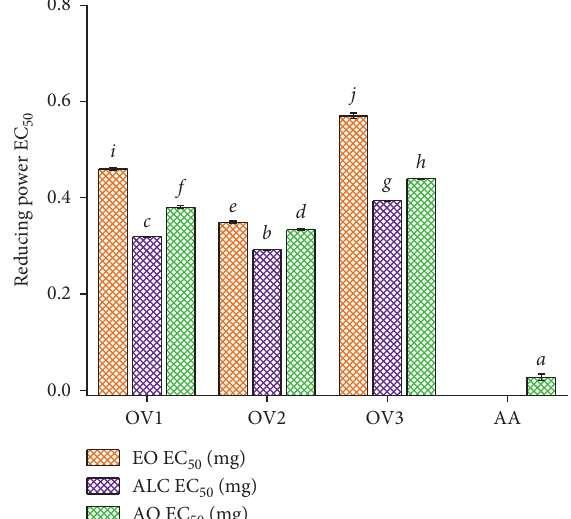
Figure 7: EC 50 plot of the reducing power ability of essential oil (EO) and alcoholic (ALC) and aqueous (AQ) extracts of Origanum vulgare from different locations, i.e., Auli (OV1), Pithoragarh (OV2), and Haldwani